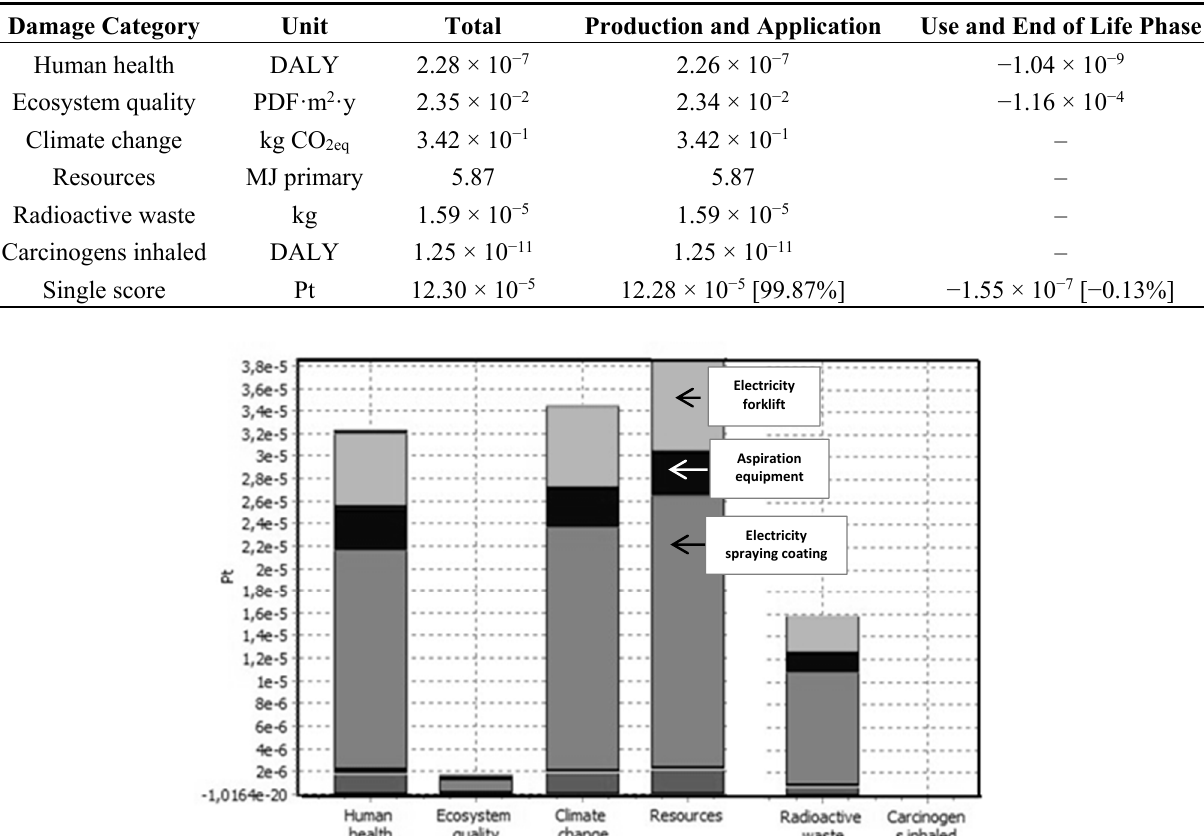
Figure 3. Evaluation by impact category of 1 m 2 of nano-TiO 2 coating on